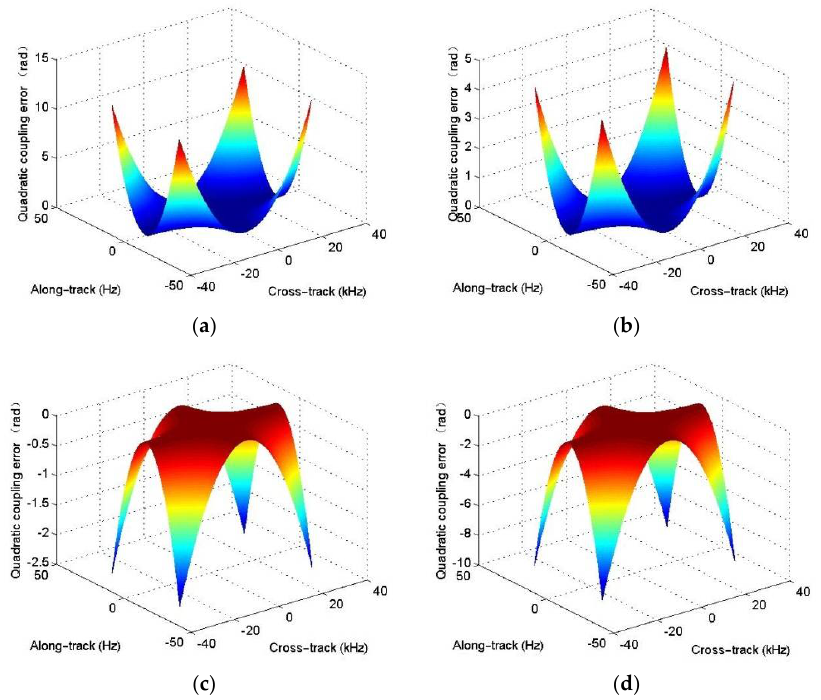
Figure 11. Residual quadratic coupling error when the system works with a wide-bandwidth. ( a ) r = 40 m; ( b ) r = 110 m; ( c ) r = 180 m; ( d ) r = 250 m. Summarily, the residual quadratic coupling error increases with the signal band- width. With the narrow-bandwidth case, this error is small. However, the wide-band- width can lead to a large residual error.